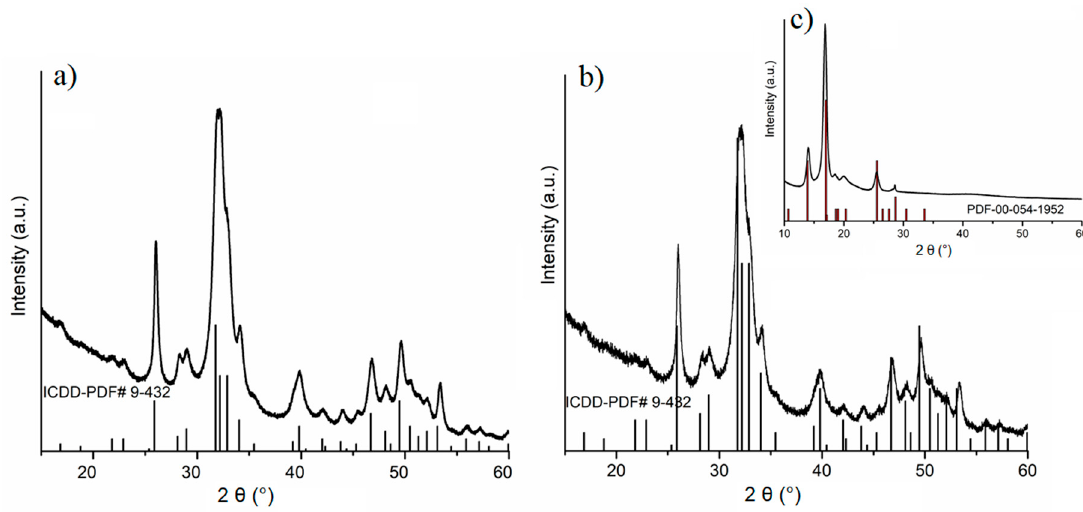
Figure 3. XRD pattern of the AgZnHApCs powder ( a ), AgZnHApCs coatings ( b ) and Chitosan ( c ) and the standard pattern of the HAp (JCPDS card No.09-0432) and Chitosan PDF-00-054-1952. FTIR analysis revealed the presence of chitosan on the AgZnHApCs suspension and